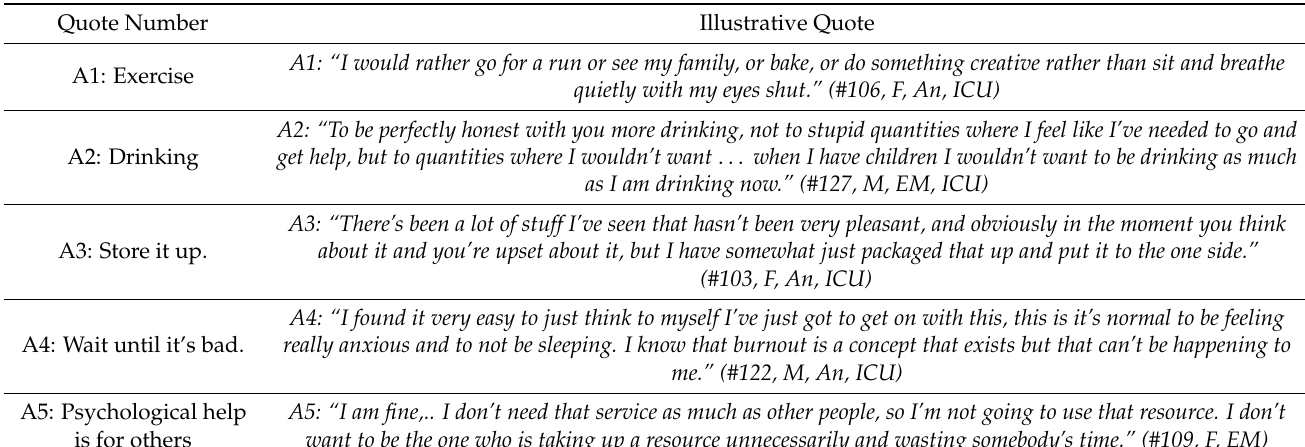
Table 4. Illustrative quotes for Coping Strategies